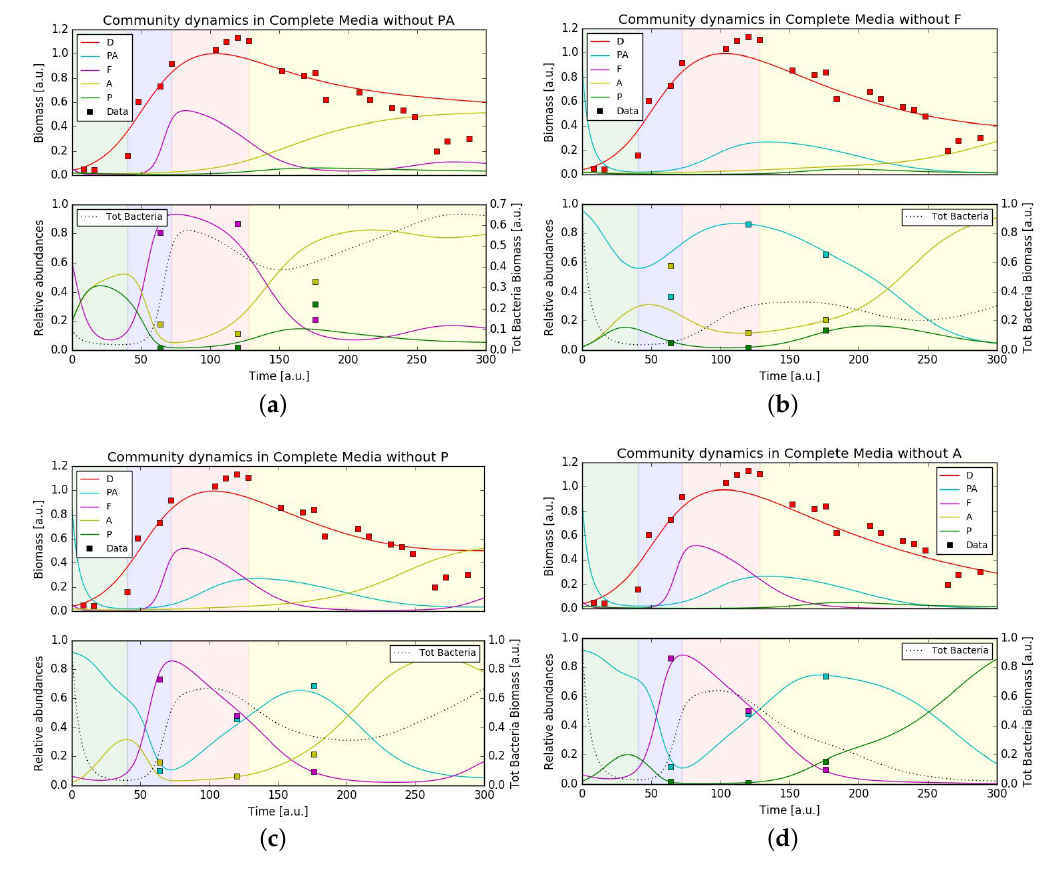
Figure 5. Reduced community simulation results (lines) and experimental data (squares) for communities of P. tricornutum ( D ), Pseudoalteromonadaceae ( PA ), Flavobacteriaceae ( F ), Alteromonadaceae ( A ) and Pseudomonadaceae ( P ) in complete media conditions. Simulations are run removing from the bacterial community one member: ( a ) PA ; ( b ) F ; ( c ) P ; ( d ) A . The top panel shows the biomass time course (arbitrary units) for the four organisms and the rescaled data points (squares) for the P. tricornutum . The bottom panel shows the variations in relative abundances of the three bacteria (single bacteria biomass/total bacteria biomass) over time and the three sets of data points from the sequencing analysis (the first data point is used as starting condition at time 0). Also shown in the bottom plot (dotted line, right y -axis) is the total bacterial biomass in arbitrary